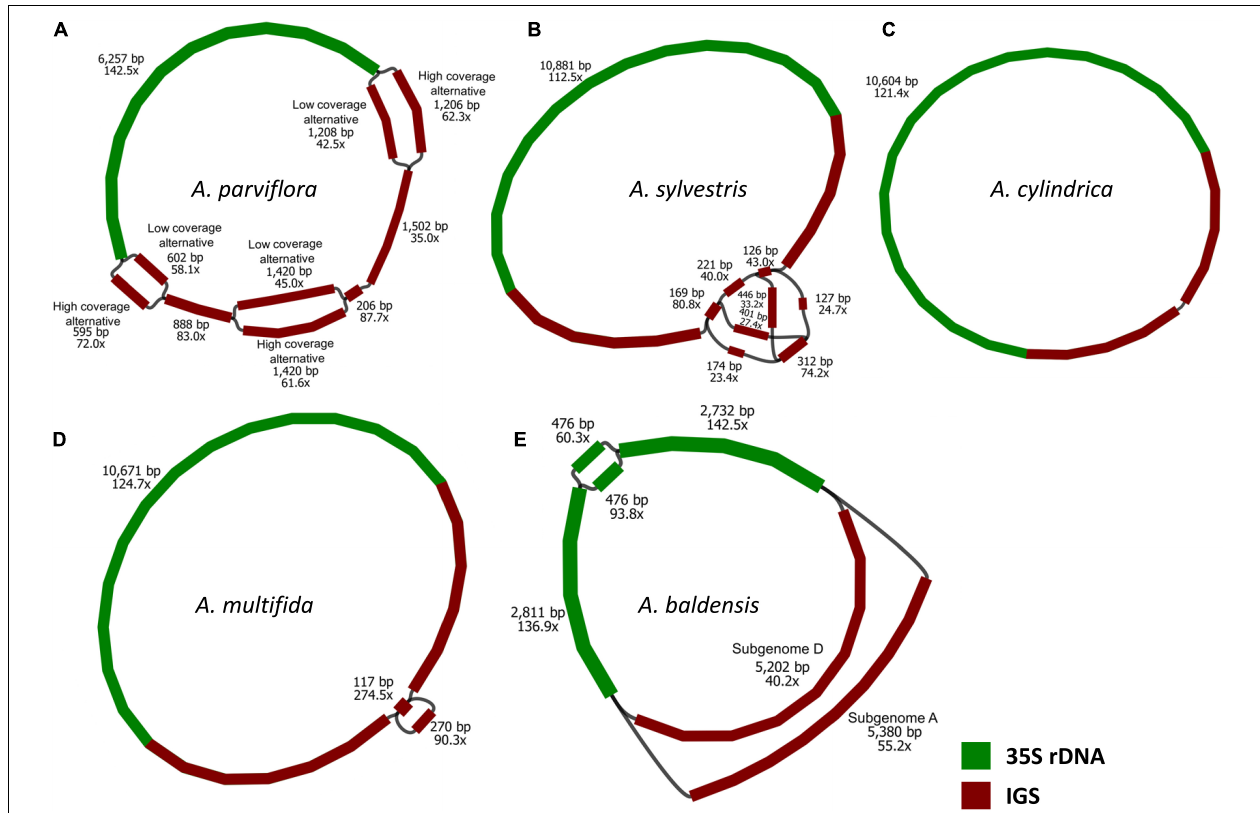
FIGURE 2 | Graphical outputs from GetOrganelle showing assembled 35S rDNA array: (A) A. cylindrica , (B) A. sylvestris , (C) A. parviflora , (D) A. multifida and (E) A. baldensis . The colors represent IGS region (red) and 35S rRNA region